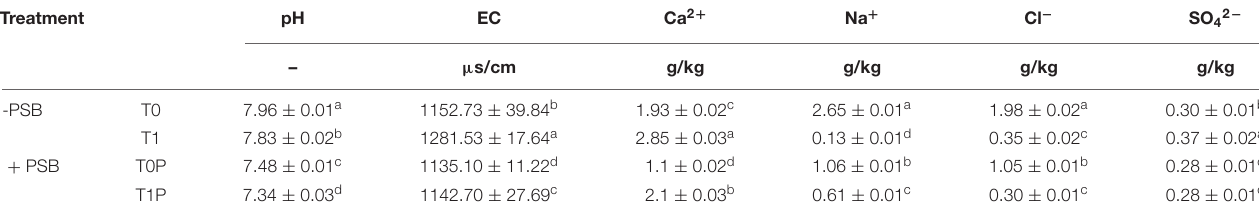
TABLE 3 | Effects of rock phosphate (RP) and phosphate-solubilizing bacteria (PSB) on soil physicochemical properties. Treatment pH EC Ca 2 + Na +